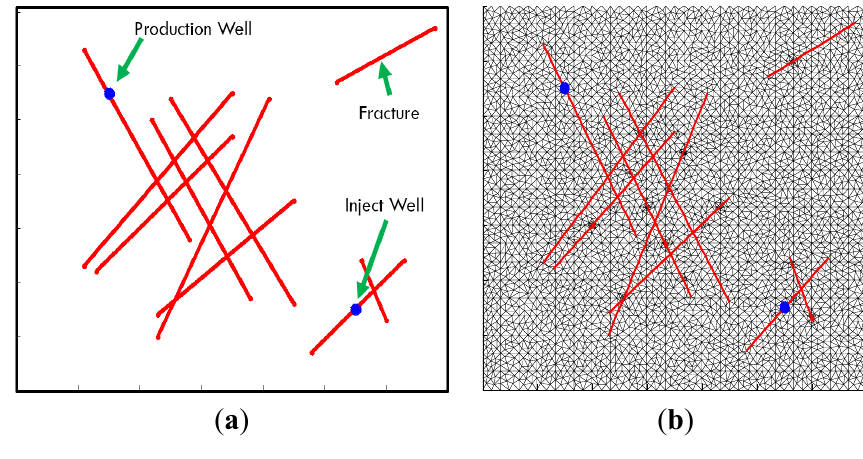
Figure 3. Case 1 model ( a ) model overview; ( b ) DFM grids. Table 1. Model parameters of case